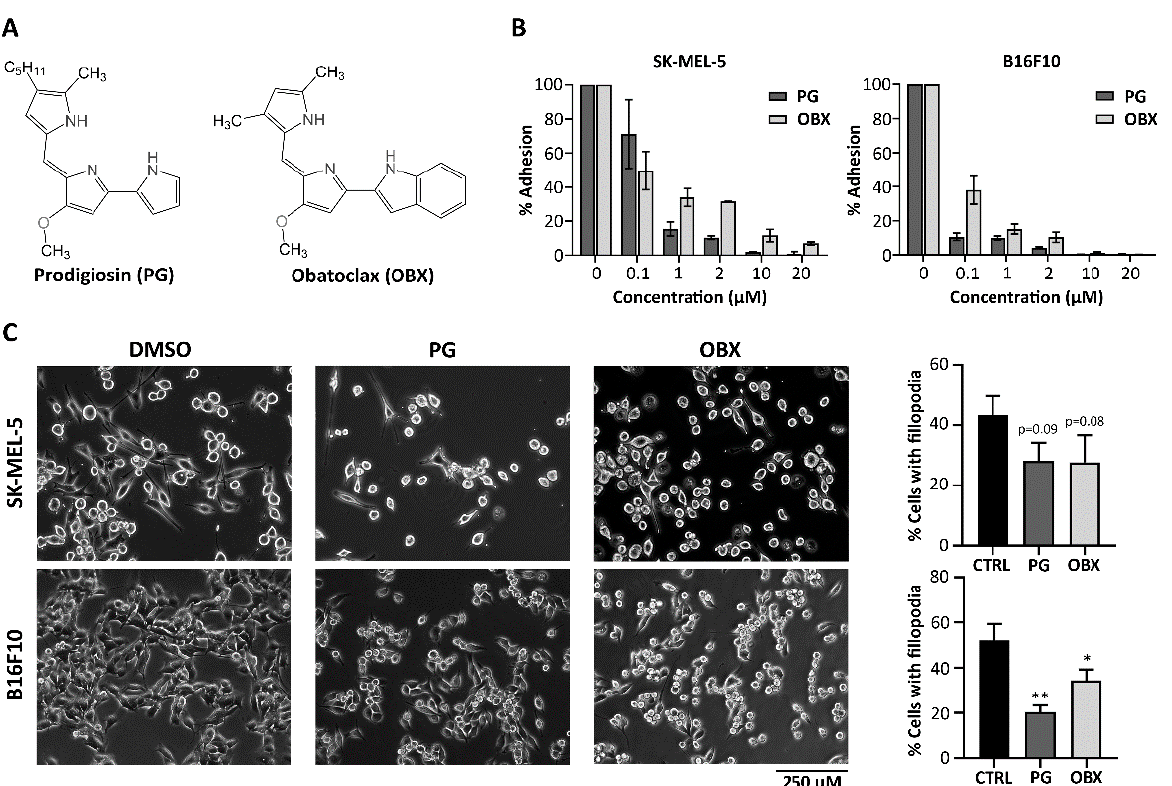
Figure 1. Adhesion and morphology of cancer cells after treatment with prodigiosin (PG) and obatoclax (OBX). ( A ) Chemical structures of PG and OBX. ( B ) SK-MEL-5 or B16F10 cells treated with different concentrations of PG or OBX for 16 h were detached and reseeded and cellular-adhesion capacity was quantified. ( C ) SK-MEL-5 or B16F10 cells filopodia were evaluated and quantified after 24 h of treatment with PG or OBX. Representative images from three independent experiments are shown. Figure shows mean ± SD. Statistical differences against control (CTRL) are shown as ** p < 0.01 and * p < 0.05.